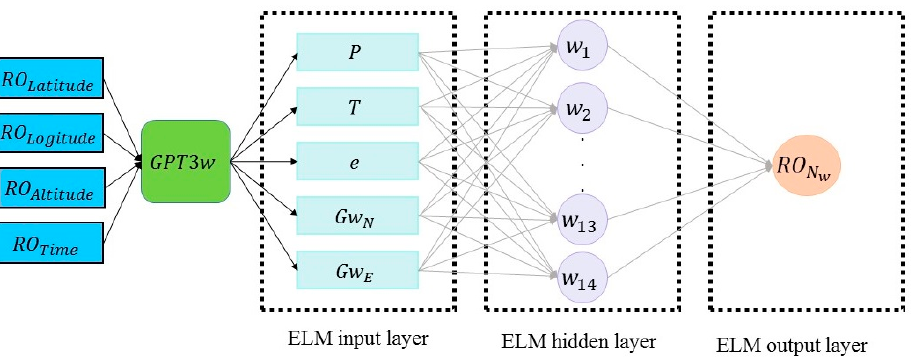
Figure 7. An overview of the parameters and layers in the ELM. The model is built for 285 patches.